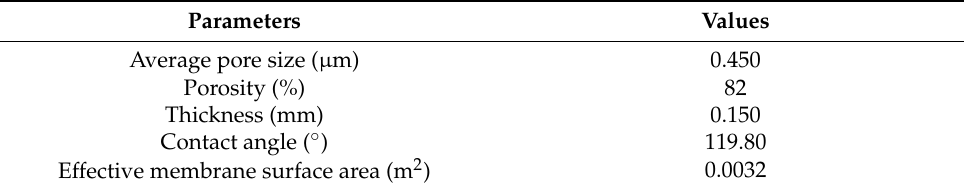
Table 1. Parameters of PVDF-H membrane.